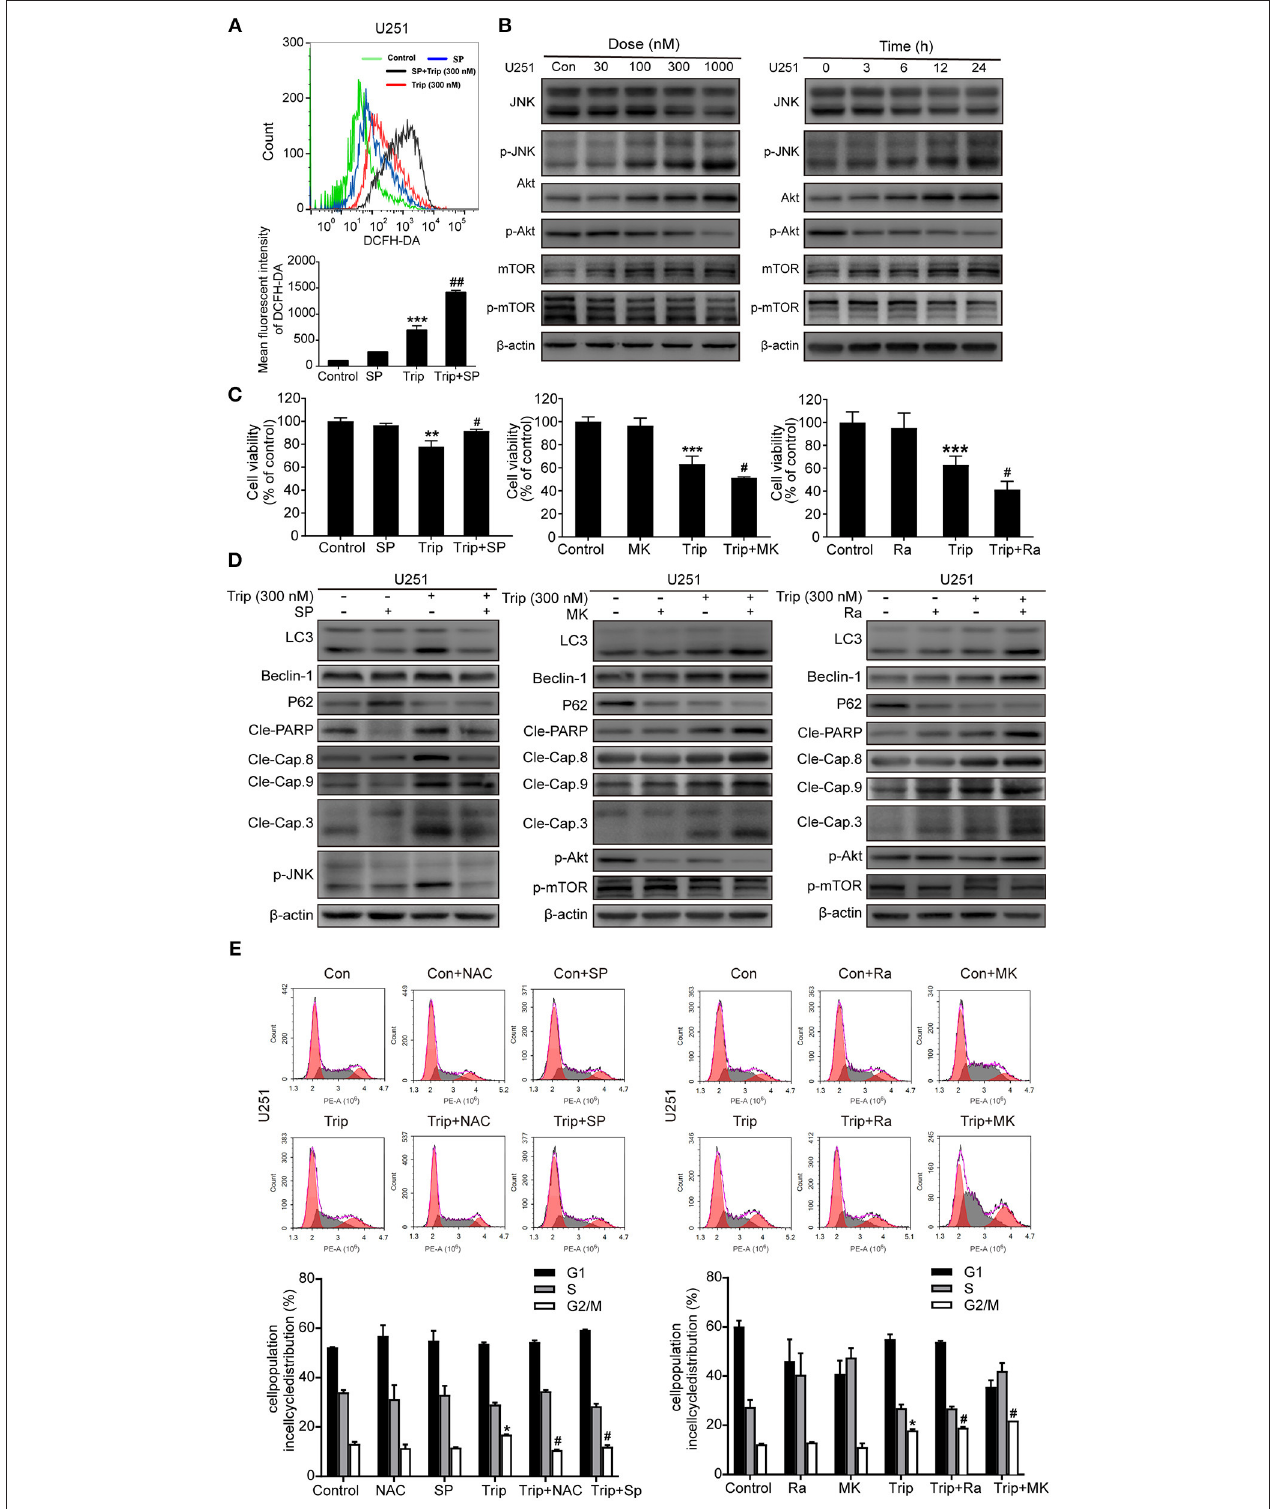
FIGURE 6 | Triptolide induced autophagy and apoptosis via the activation of the ROS/JNK and inhibition of the Akt/mTOR signaling pathways. (A) U251 cells were pretreated with SP (40 µ M) for 2h, followed by treatment with triptolide (300nM) for an additional 12h. The ROS level was determined by flow cytometry. The dataarepresentedasthemeans ± SD( n = 3). (B) AftertreatingtheU251cellswithvariousconcentrationsoftriptolidefor24hor300nMtriptolidefordifferentdurations,